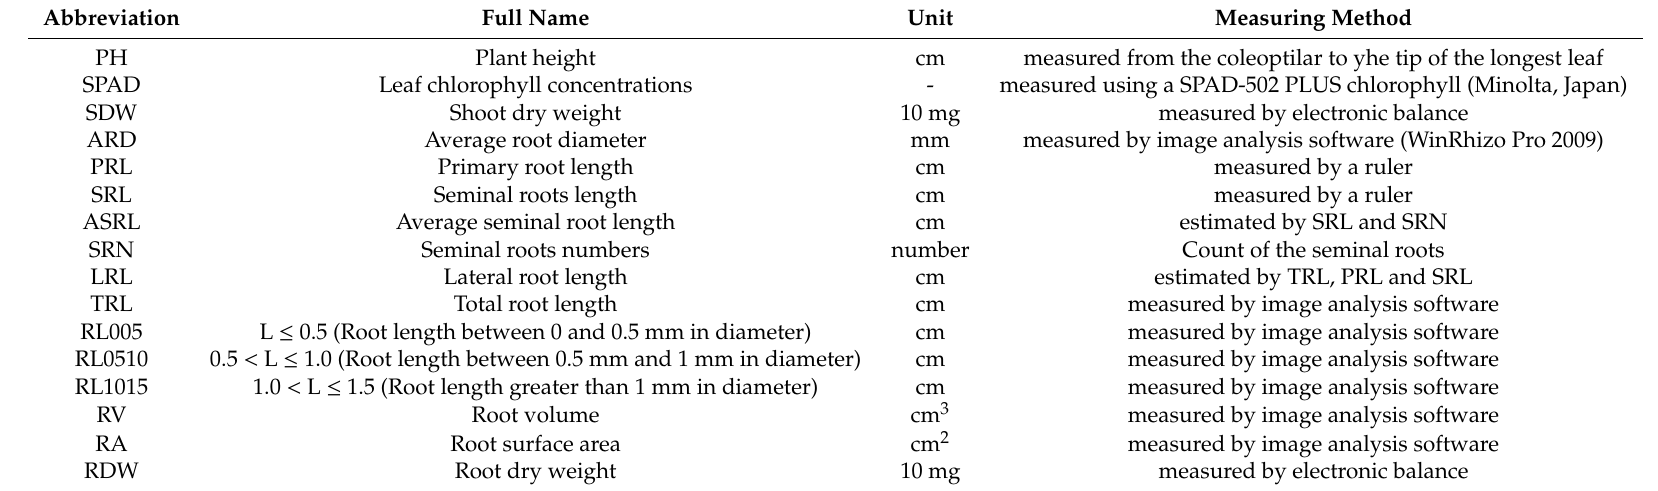
Table 1. Summary of the root and shoot traits and their